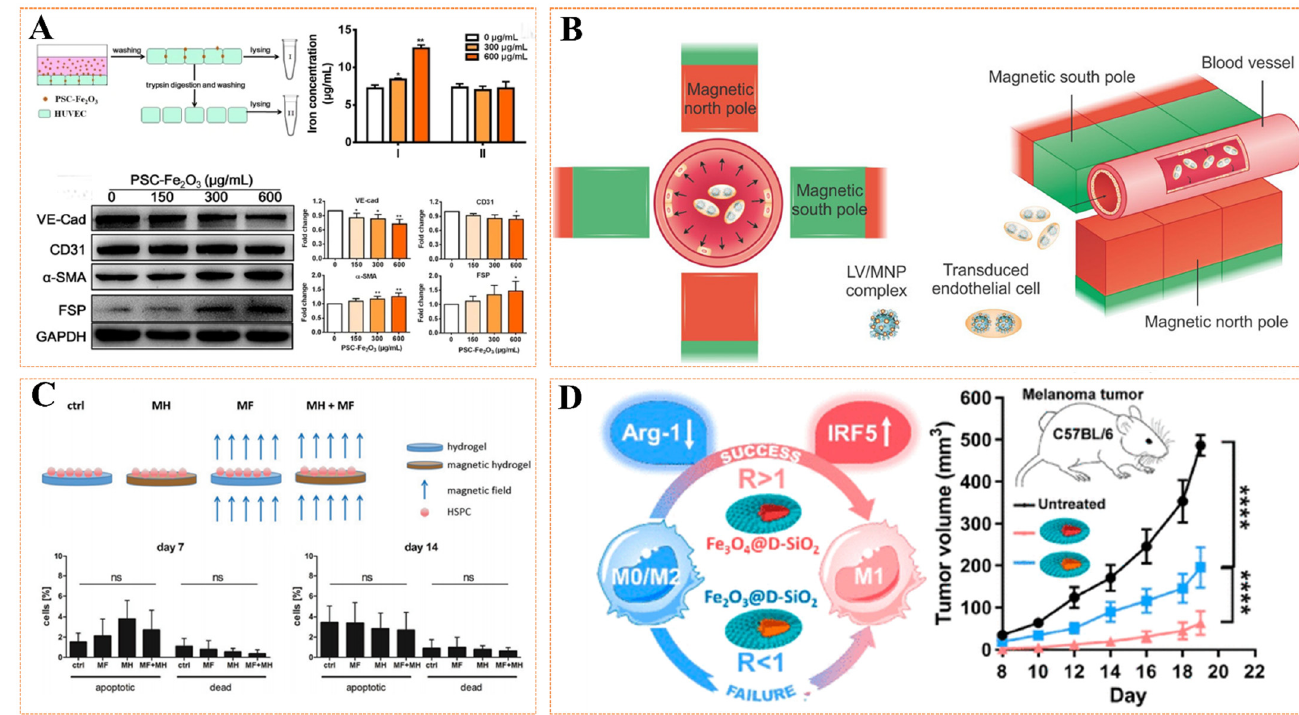
Figure 4. ( A ) Magnetic nanoparticles (Fe 2 O 3 @PSC)-labeled VECs and their effects on the expression